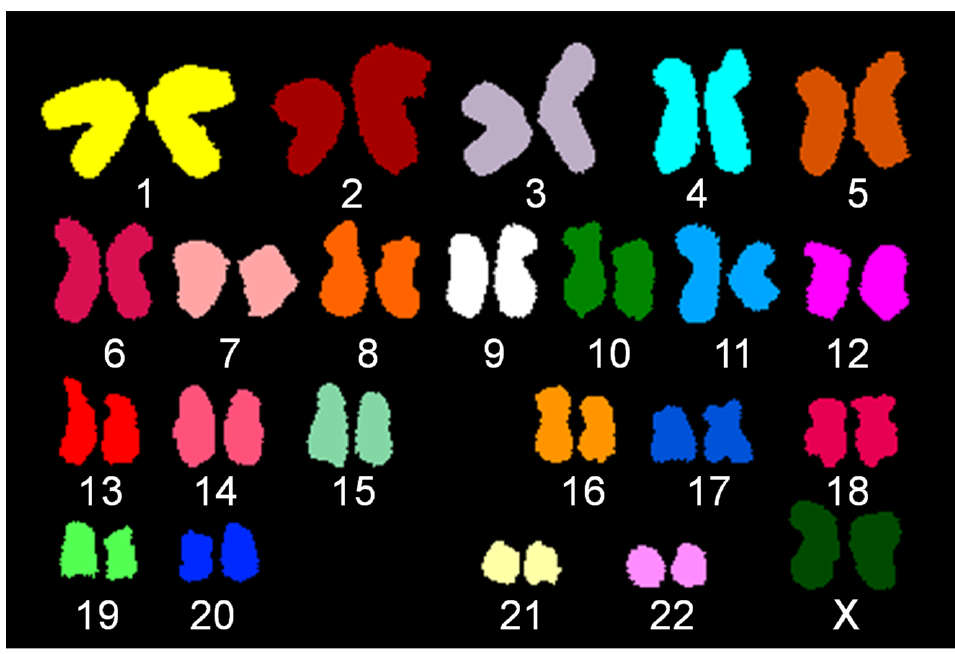
Figure 3. Classified image from Spectral Karyotype (SKY) of HUVECs. Classified image shows no interchromosomal translocation.